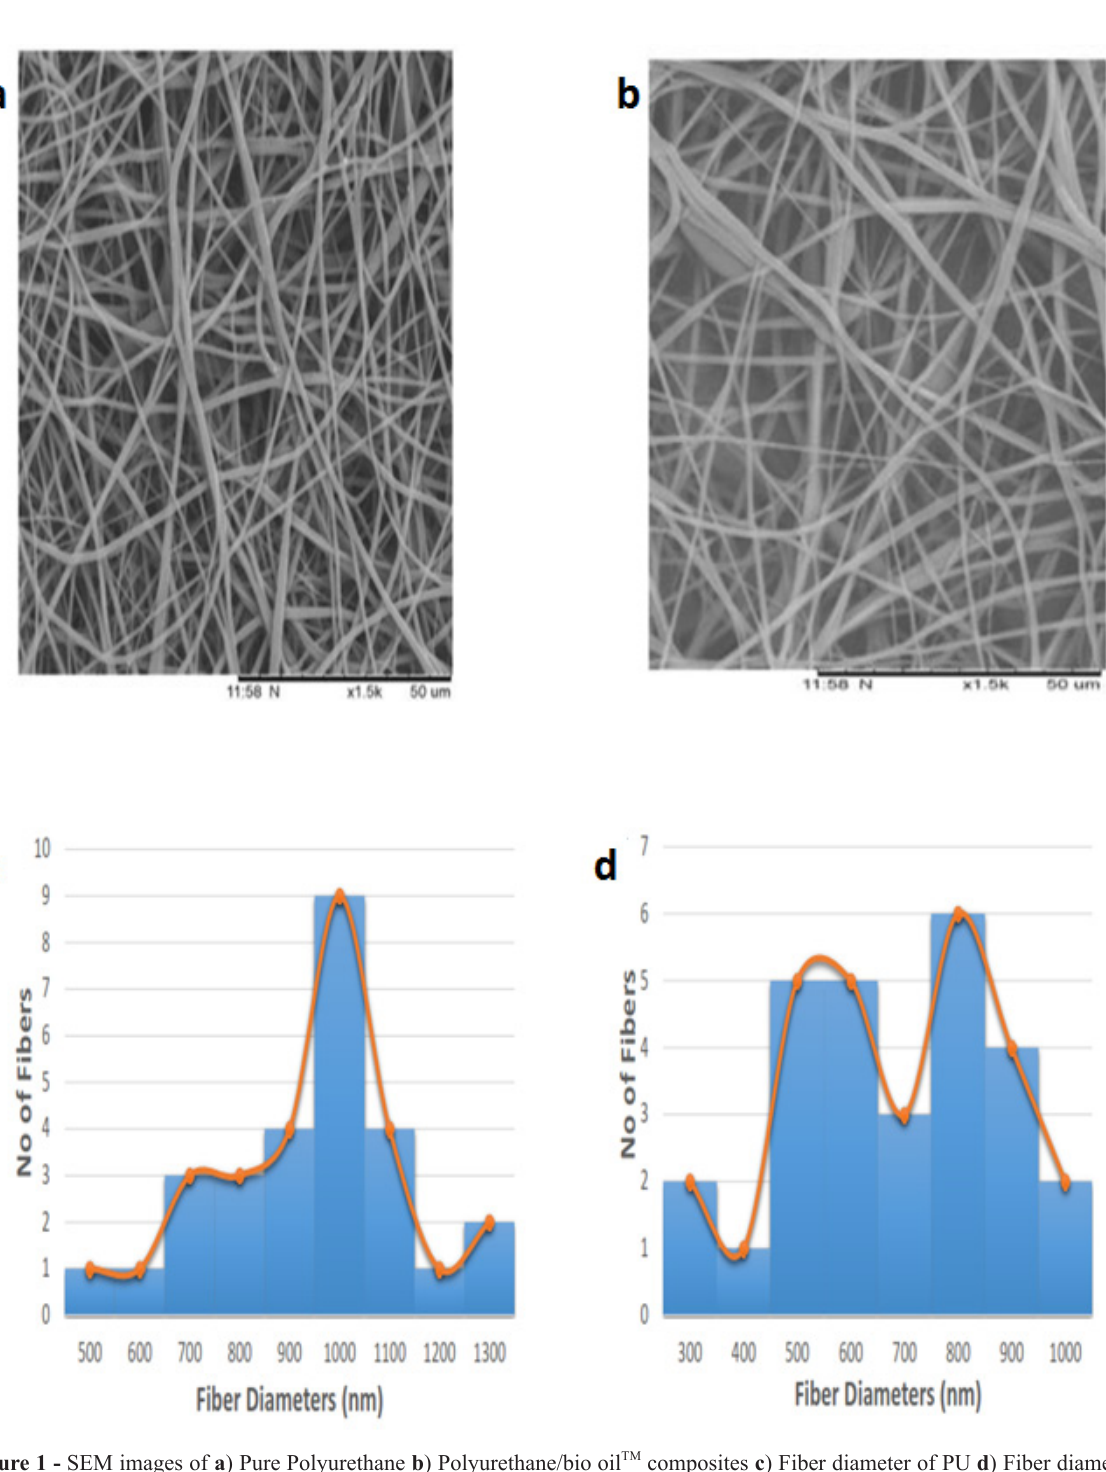
Figure 1 - SEM images of a ) Pure Polyurethane b ) Polyurethane/bio oil TM composites c ) Fiber diameter of PU d ) Fiber diameter of PU/bio oil TM